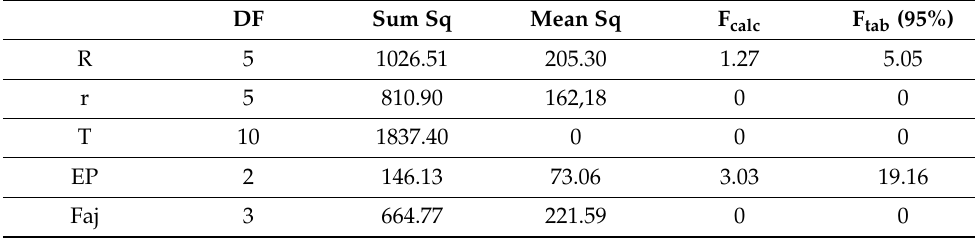
Table 1. Anova table for 2 3 factorial design with center